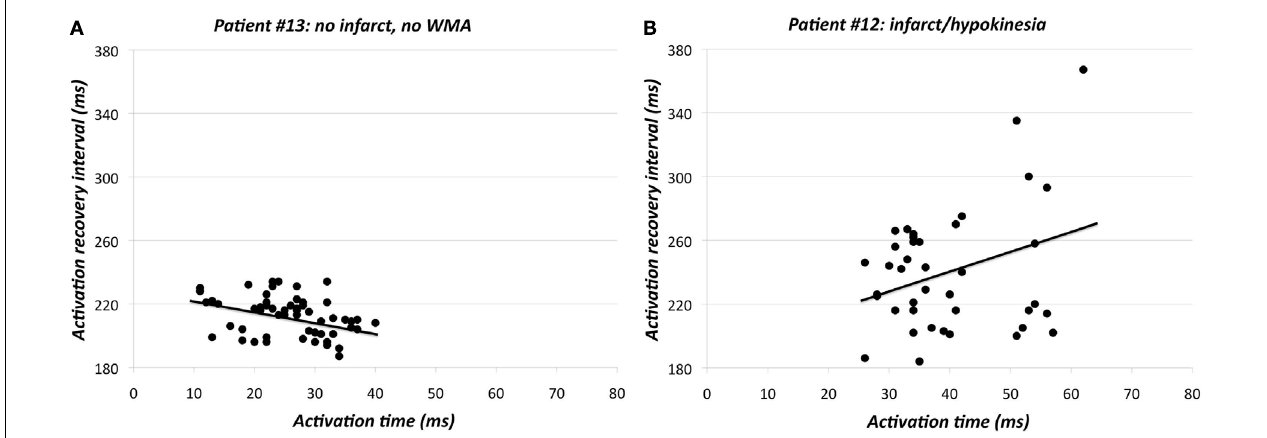
FIGURE 7 | (A) Activation time vs. activation-recovery intervals in patient #13 (see also Figure 3 ; Table 2 ). Y =− 0.59 X + 228; r =− 0.349, p < 0.005. (B) Activation time vs. activation-recovery intervals in patient #12 (see also Figure 3 ; Table 2 ). Y = 1.11 X + 196; r = 0.287, p < 0.05.